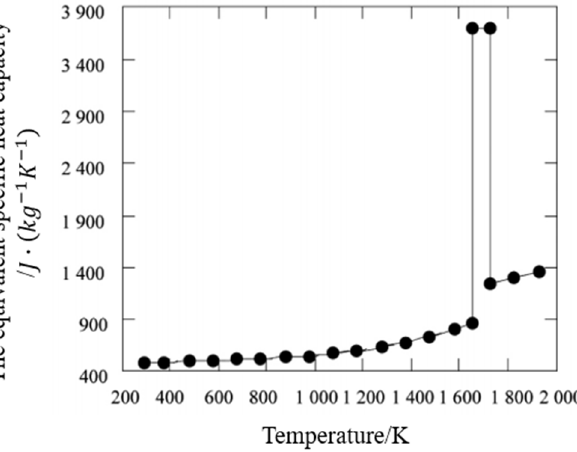
Figure 10. Equivalent specific heat capacity of 316L stainless steel powder at different temperatures.